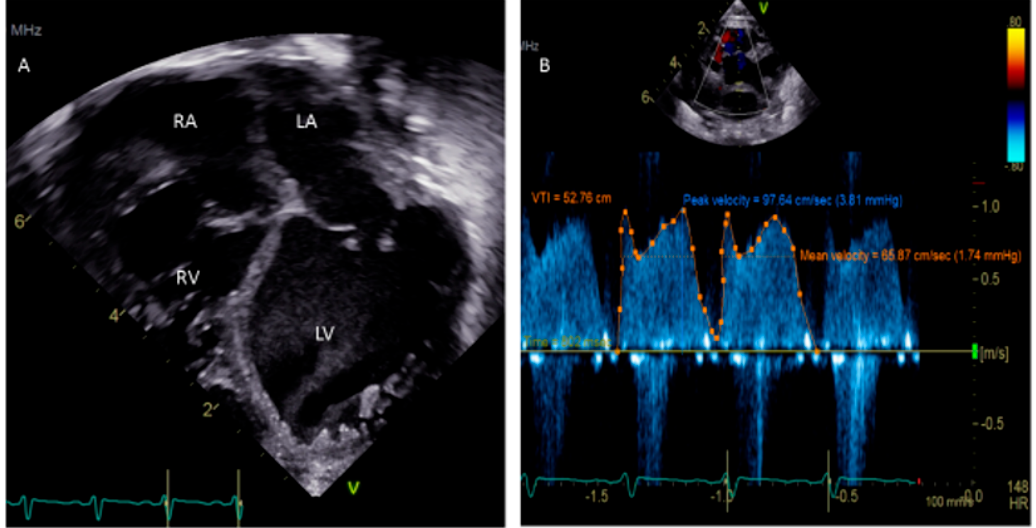
Figure 3. ( A ) Apical 4-chamber view showing dilated cardiomyopathy in a 5 week old child. ( B ) Doppler of PFO showing peak velocity 3.81 mm Hg and mean 1.74 mm Hg. of PFO showing peak velocity 3.81 mm Hg and mean 1.74 mm